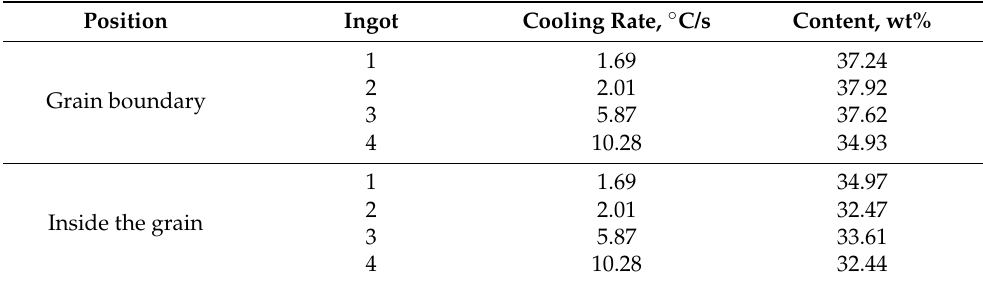
Table 4. Average Mn content in the center of the ingot with different diameters.